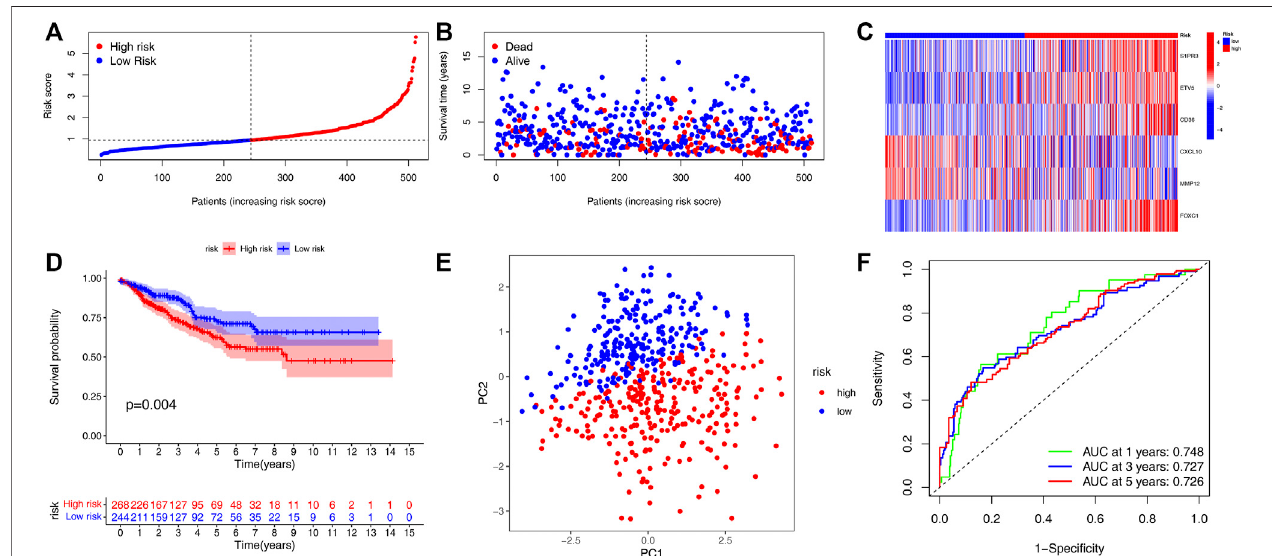
FIGURE 4 | Validation of the HRG-score signature in the testing set. (A,B) Ranked dot plot indicates the PRG-score distribution, and the scatter plot presents the patients ’ survivalstatus. (C) Heatmap oftheexpressionofsixgenesinvolvedintheHRG-scoreinlow-and high-riskgroups. (D) KM analysisoftheOSbetweenthelow- and high-risk groups. (E) PCA demonstrated that the patients in the different risk groups were distributed in two directions. (F) ROC curves to predict the sensitivity and speci fi city of 1-, 3-, and 5-year survival according to the